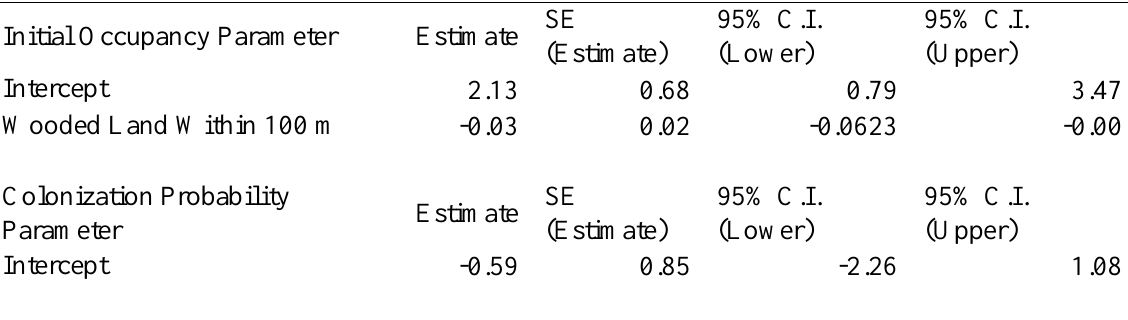
Table A3.B. Third-highest-ranking multi-season occupancy model (AIC AIC weight=0.08) for Clay-coloured Sparrows along 47 transmission line study sites in Winnipeg, Manitoba, Canada in 2008-2009 (n=276 surveys), assuming no effect of mowing on probability of colonization or extinction, and effects of Julian date and time of morning but not observer experience on probability of detection given presence at